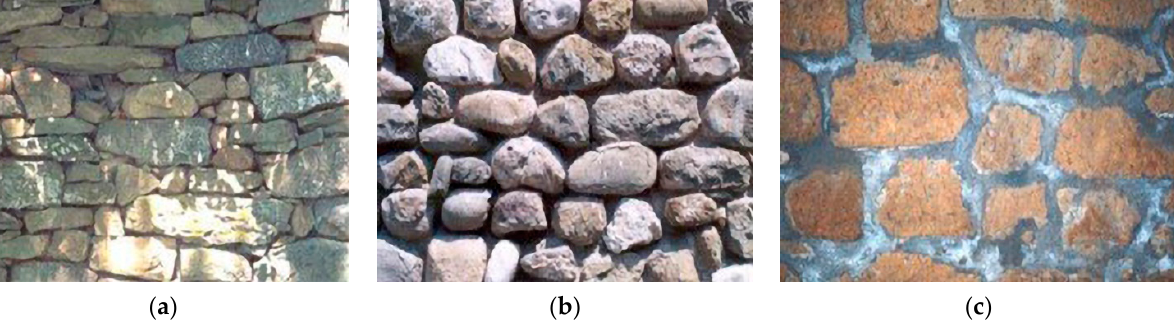
Figure 5. Examples of irregular/rubble masonry: ( a ) semi-finished stone masonry; ( b ) stone masonry with rounded ashlar; ( c ) irregular tuff masonry.